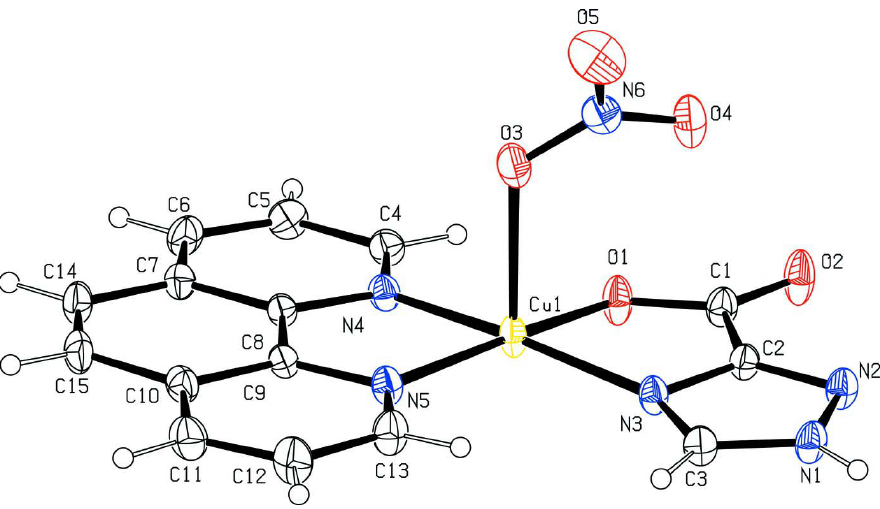
Figure 1 The molecular structure of the title compound showing 30% probability displacement ellipsoids and the atom-numbering scheme.